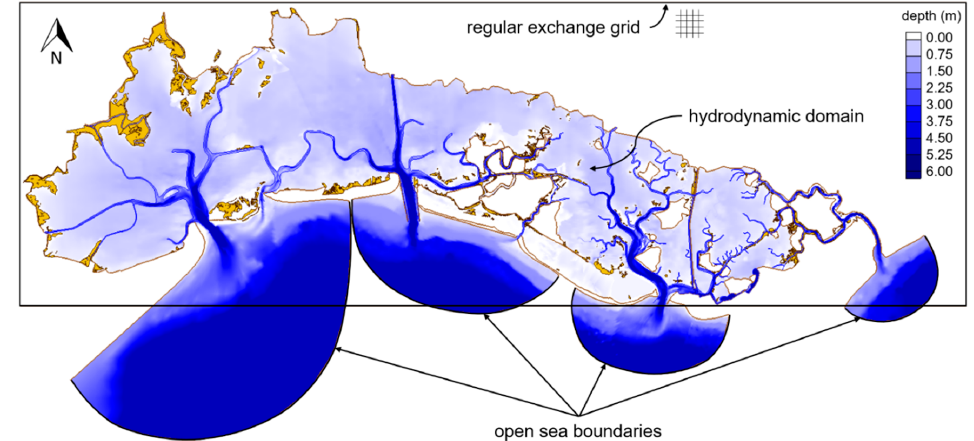
Figure 2. Computational domains used in the simulations: the morphological-hydrodynamic structured mesh reproducing Marano and Grado Lagoon and the regular exchange grid. The mesh of SWAN (Simulating WAves Nearshore) comprises only the lagoon extension.